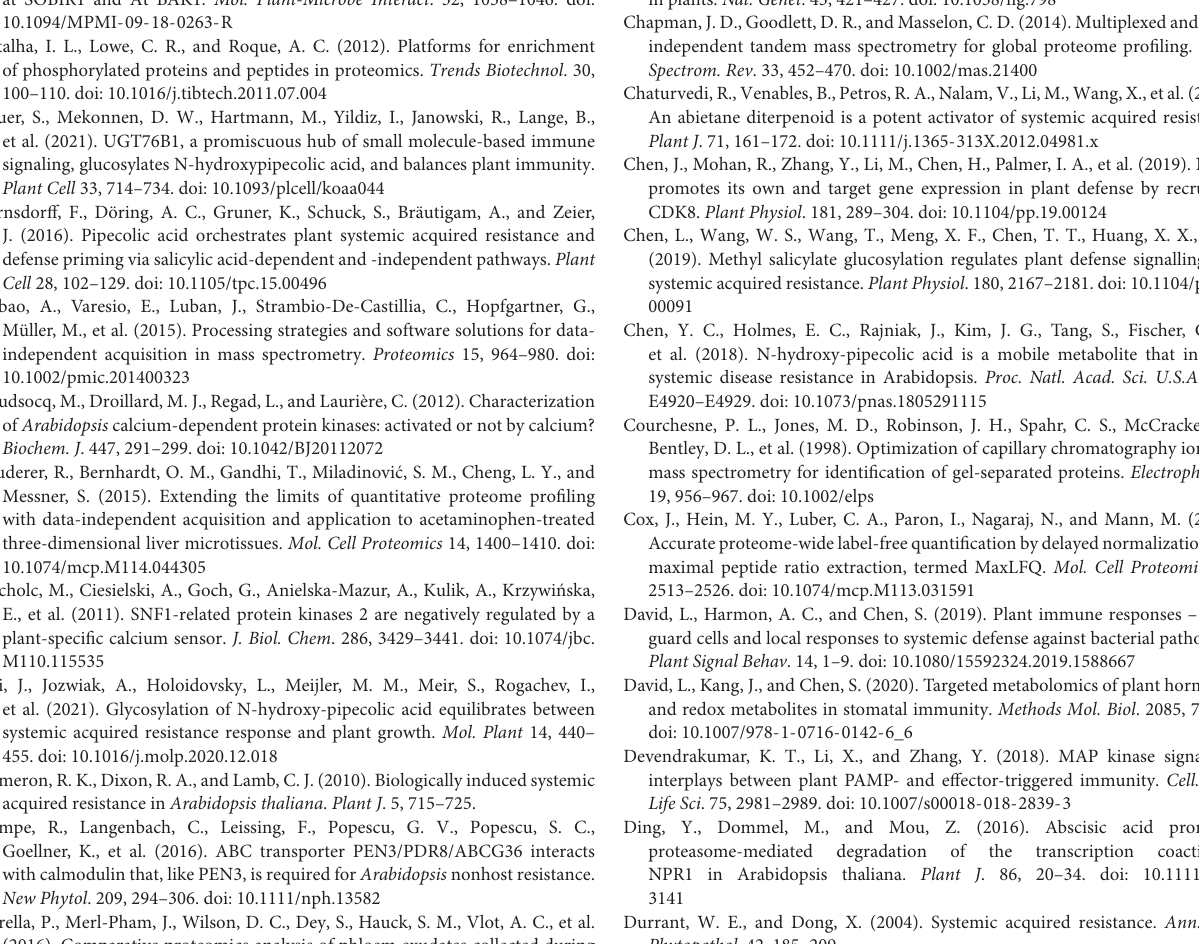
Supplementary Table 7 | Differentially phosphorylated RLKs, CDPKs, and MAPKs.